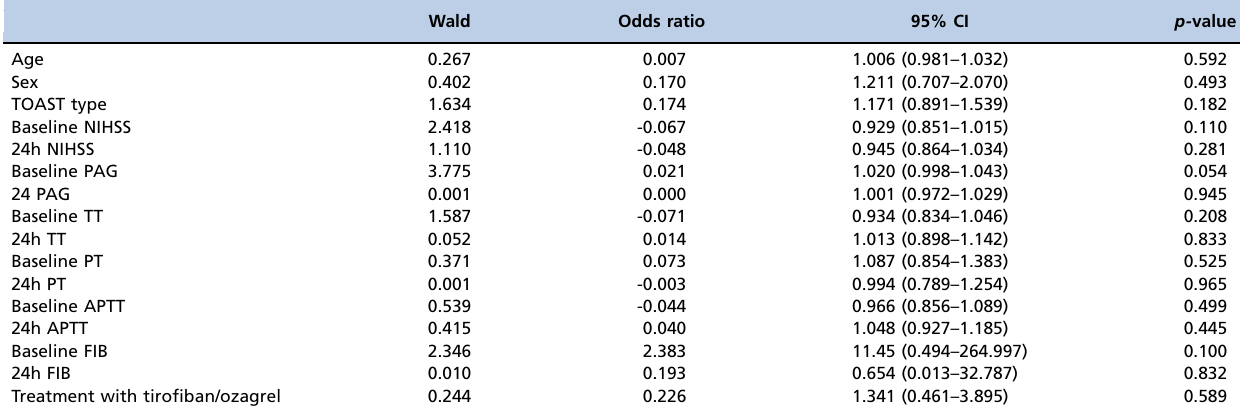
Table 4 - Logistic regression analysis of clinical risk factors affecting long-term disability in stroke patients.